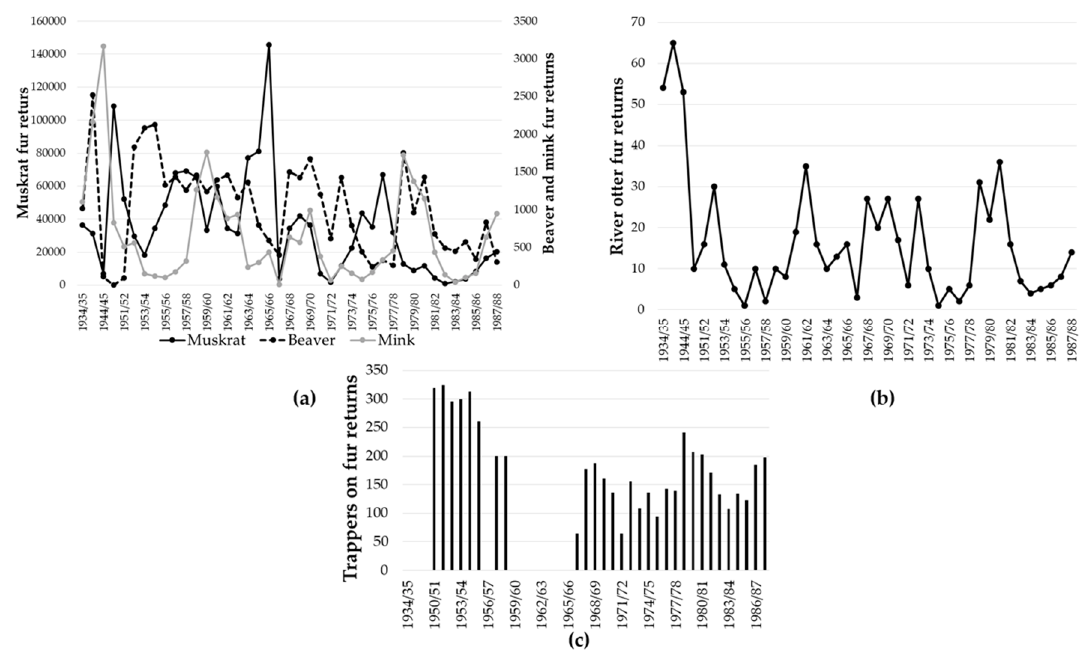
Figure 2. Fur returns muskrat, beaver, mink ( a ), and river otter ( b ), and number of trappers ( c ) for the Wood Buffalo National Park from 1934 to 1988. Source: Wood Buffalo National Park trapping records.